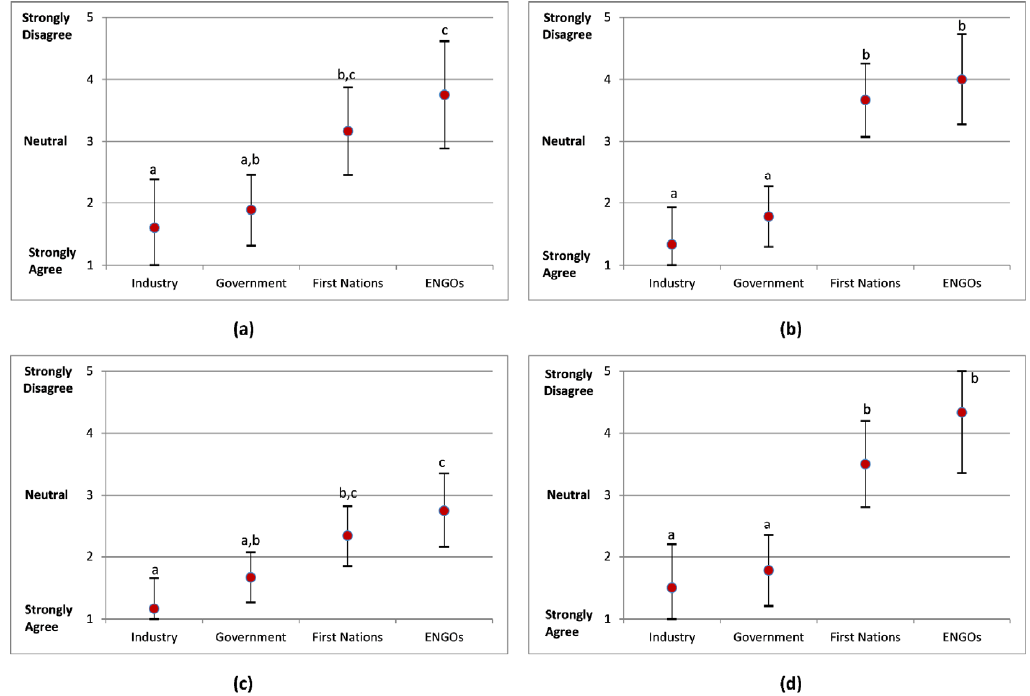
Figure 4. Mean levels of agreeance and 95% confidence intervals by group to the following statements: ( a ) advantages of MAS outweigh the disadvantages; ( b ) attitude towards the use of MAS in the forests of BC is positive; ( c ) support the continued investigation and research in genomic tools; ( d ) support the implementation of MAS in BC forests. Significant differences are identified with lowercase letters, where different letters indicate a statistically significant difference between groups.